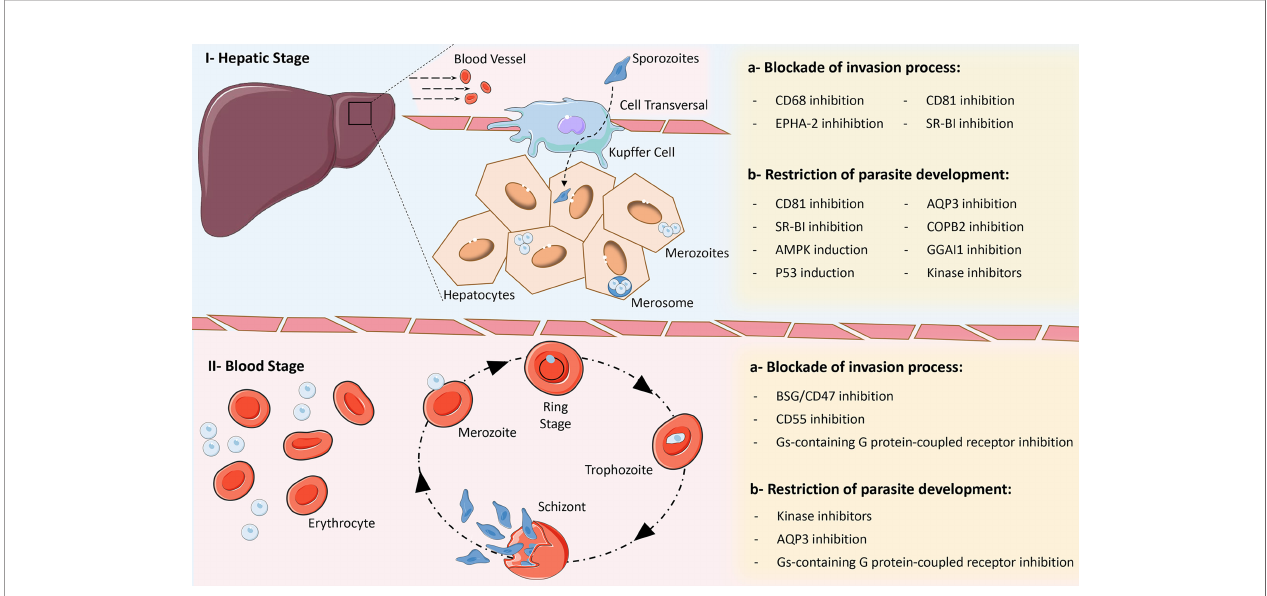
FIGURE 2 | Main strategies for the development of Host-Directed Therapies for malaria. Due to complex biology of Plasmodium parasites, several opportunities for intervention within biological processes exist in the different phases of the parasite ’ s life cycle, which can block cell invasion and promote improved parasite clearance or restrict their development within host cells. I – Hepatic stage: a) inhibition of CD68, EPHA-2, CD81 and SR-BI can block the invasion of hepatocytes by different Plasmodium species; b) inhibition of CD81, SR-BI, AQP3, COPB2, GGAI1 and the activity of some kinases, as well as induction of p53 and AMPK expression, can restrict the development of different Plasmodium species within hepatocytes. II – Blood stage: a) inhibition of BSG/CD47, CD55 and activity of G a s- containing G protein-coupled receptors can block the invasion of red blood cells by different Plasmodium species; b) inhibition of the activity of some kinases and G a s-containing G protein-coupled receptors, as well as blockade of the AQP3 receptor can restrict the development of different Plasmodium species within red blood cells. Some elements in this fi gure use pictures from Servier Medical Art (https://smart.servier.com) licensed under a Creative Commons Attribution 3.0 Unported License